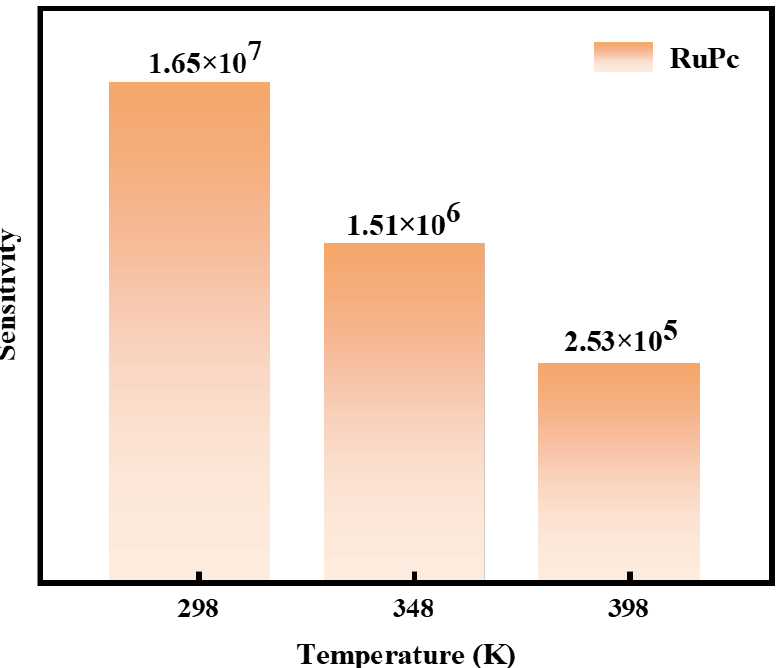
Figure 8. Sensitivity of RuPc monolayer towards the CH 2 O gas at different temperatures.